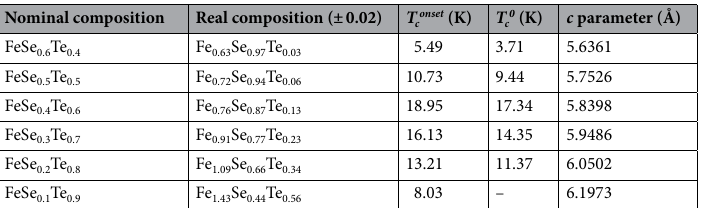
Table 1. The composition, onset and zero-resistivity temperature, and c -axis lattice parameter of thin films for nominal composition FeSe 1− x Te x targets.